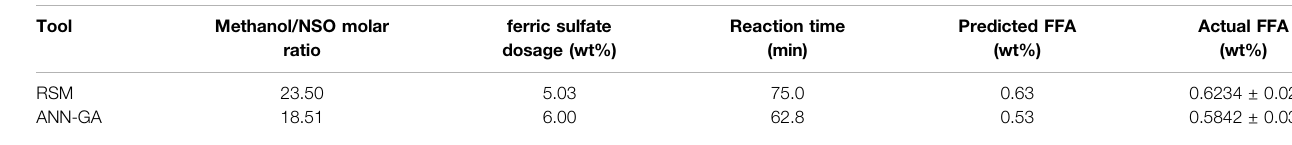
TABLE 8 | Predicted optimization conditions and experimental model